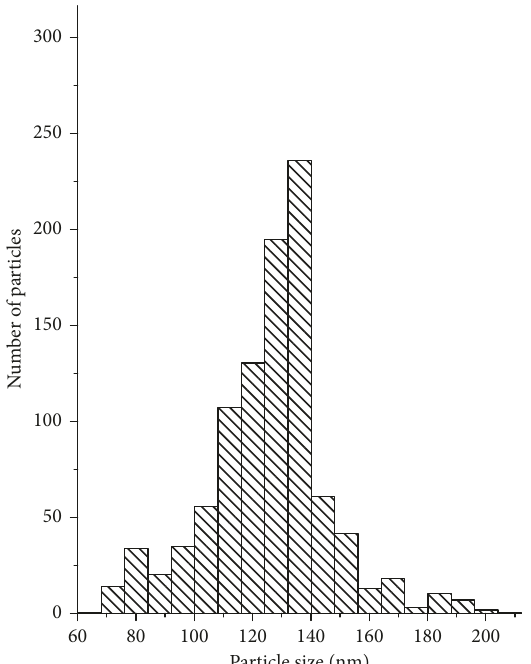
Figure 4: Histogram of the distribution of sizes.